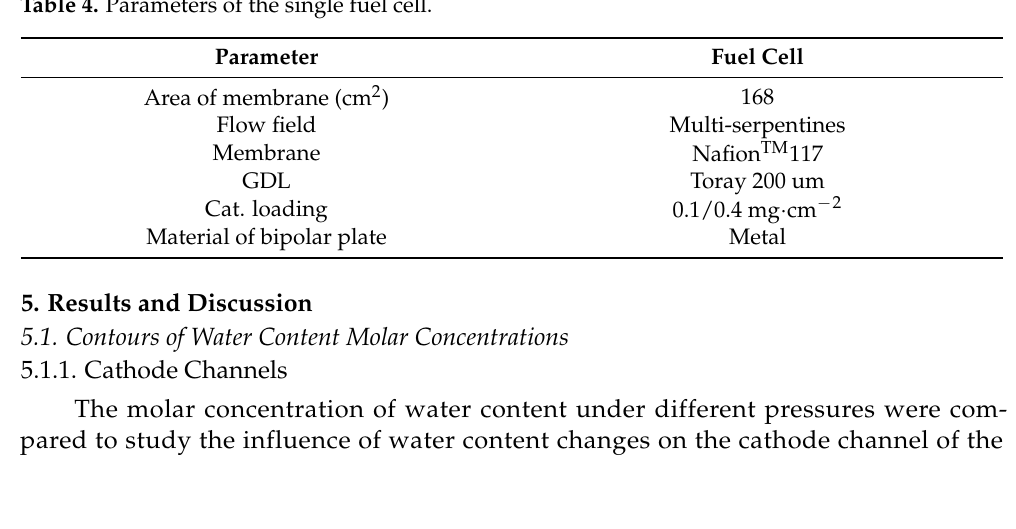
Table 4. Parameters of the single fuel cell.